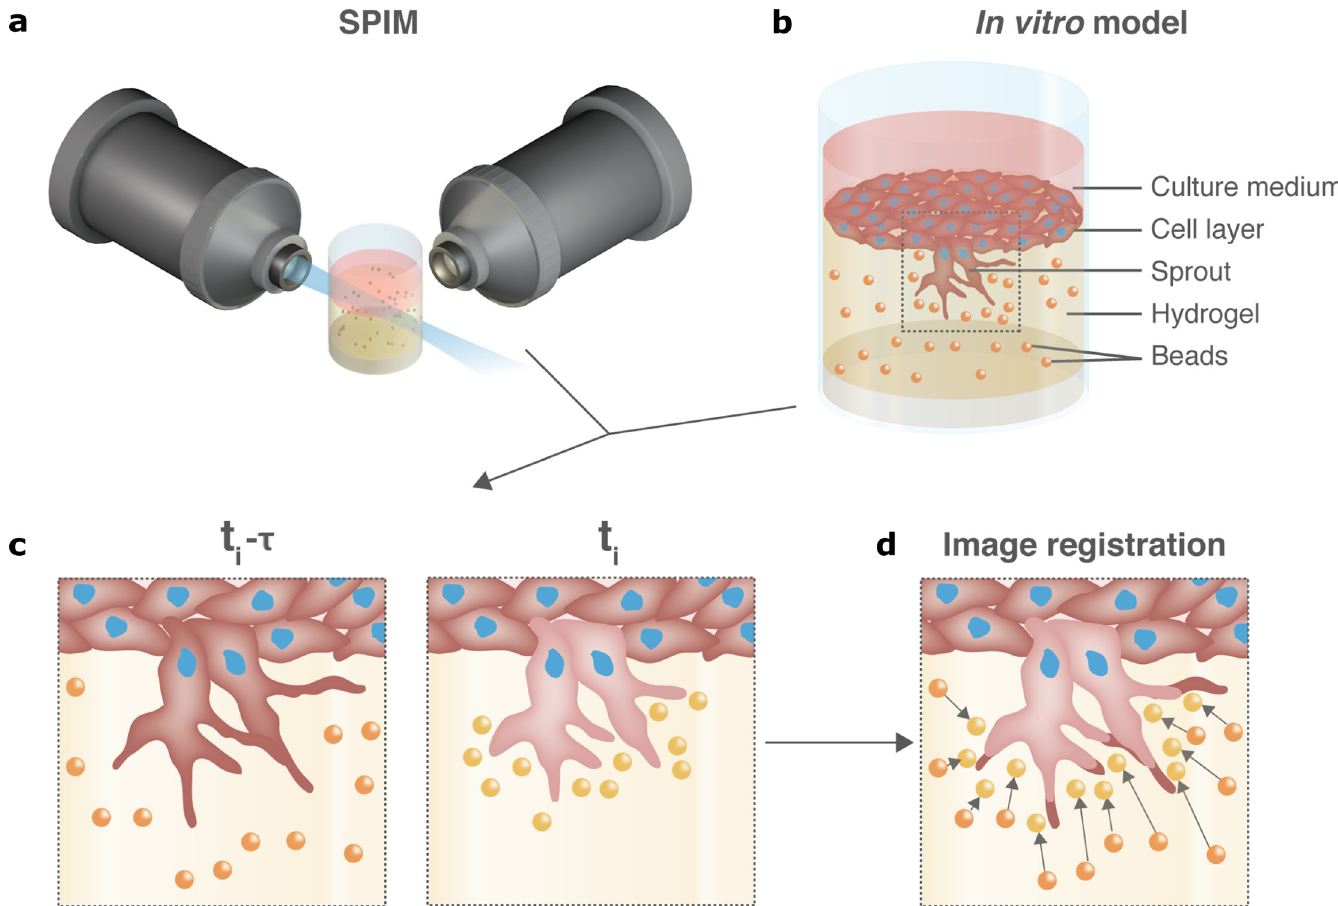
Fig 1. Workflow of 4D displacement microscopy around in vitro angiogenic sprouts. (a) SPIM setup with mounted sample (see S1 and S2 Figs for specifications). (b) SPIM-compatible i n vitro model of angiogenesis showing endothelial cells invading and sprouting into a collagen gel with embedded fluorescent beads. (c) Live fluorescence cell imaging of the sprouts and beads captures cell-matrix mechanical interactions and allows mapping sprout-induced matrix deformations by (d) registering the fluorescent beads and sprout segmentation in time.